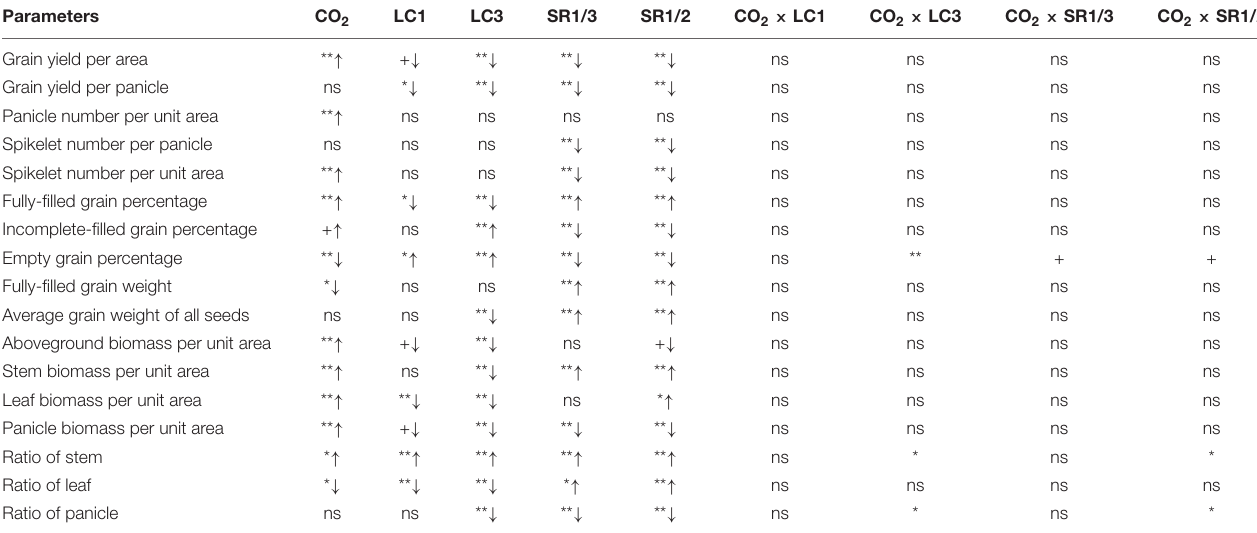
TABLE 1 | Significance test for yield, yield traits, biomass per area, and dry matter distribution of WYJ27 under elevated CO 2 and different source-sink treatments in 2017.